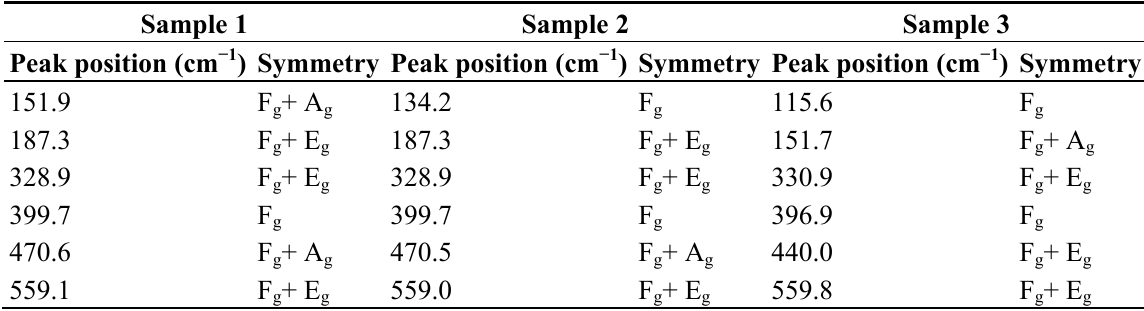
O and template assisted Y 2 3